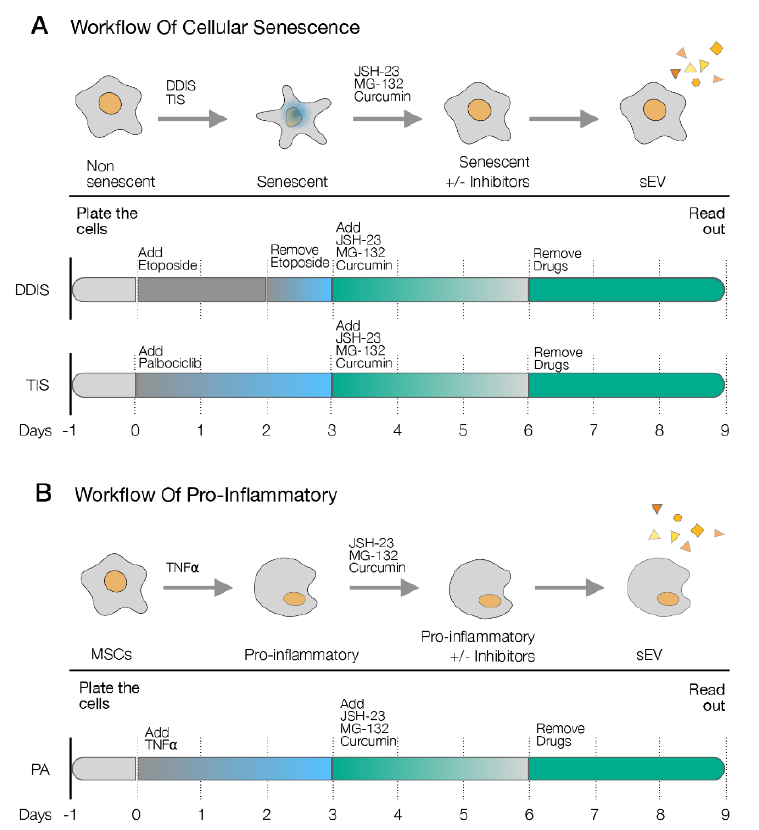
Figure 6. Schematic representation of the experimental settings to determine the role of the p65 pathway in the release of small extracellular vesicles (sEV). sEV were isolated from ( A ) cellular senescence models (DNA damage-induced senescence (DDIS) and therapy-induced senescence (TIS)) and ( B ) proinflammatory activation (PA) in mesenchymal stem cells (MSCs) after the treatment with pharmacological inhibitors (JSH-23, MG-132 and curcumin) during the induction.